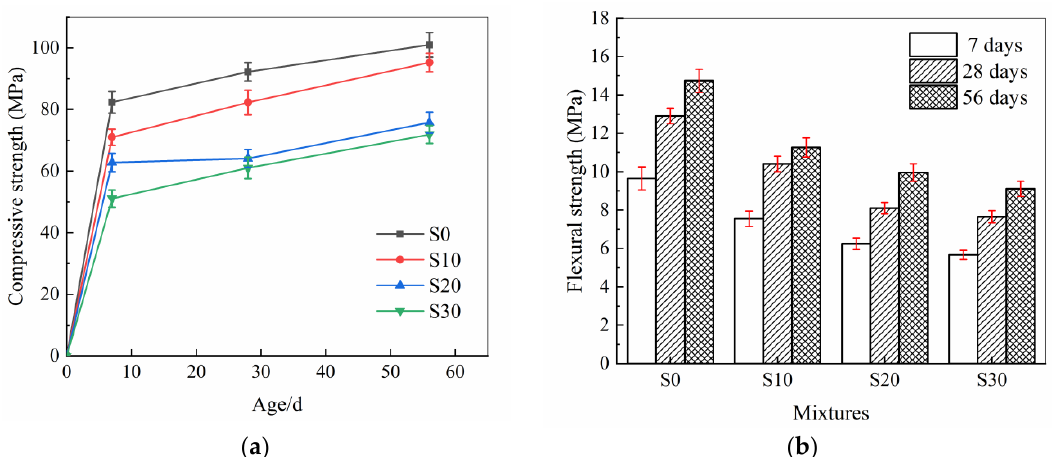
Figure 6. Effects of the content of silicomanganese slag (replacing GBFS) on compressive strength ( a ) and flexural strength ( b ) of AASSC.